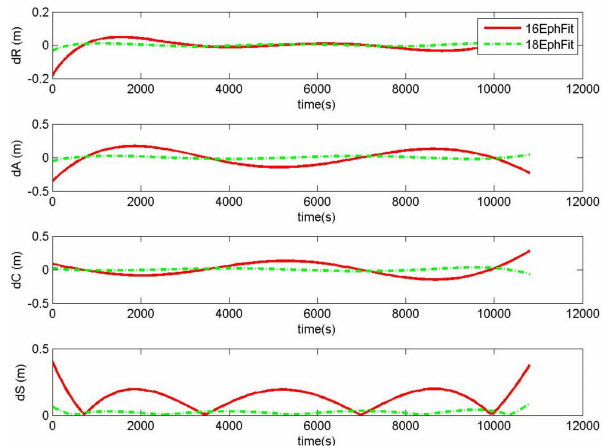
Figure 2. The errors of 18-parameter ephemeris and 16-parameter ephemeris fitting precise orbits (18EphFit and 16EphFit) during the 2-h validity period for the satellite of PRN 3 starting from UTC 2017 / 07 / 05 00:00:00.